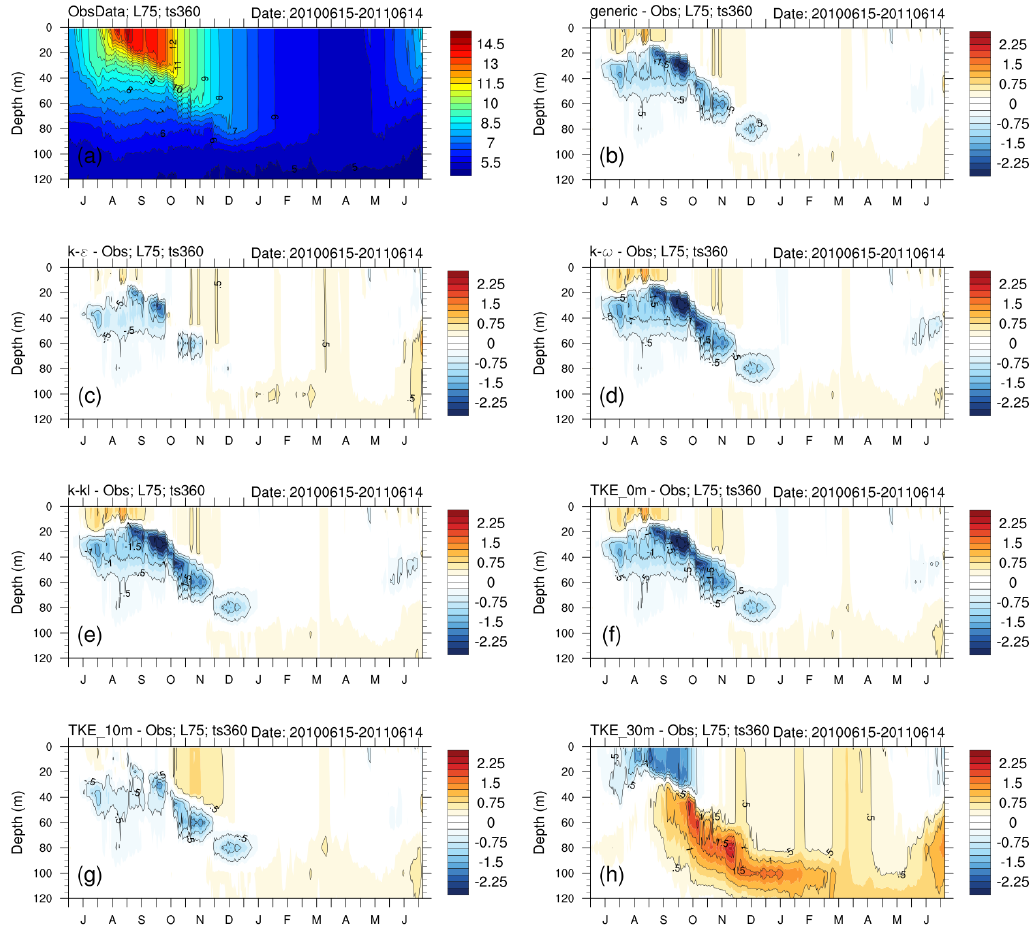
Figure 7. Observed temperature at PAPA station (a) over the study period (15 June 2010 to 14 June 2011) and the biases (model minus observed data) obtained in the simulations with all closures, with [L75; 360s]: generic (b) , k - ε (c) , k - ω (d) , k - kl (e) , TKE_0m (f) , TKE_10m (g) and TKE_30m (h) . Iso-lines are plotted every 0.5 ◦ C (except for the iso-0, which has not been